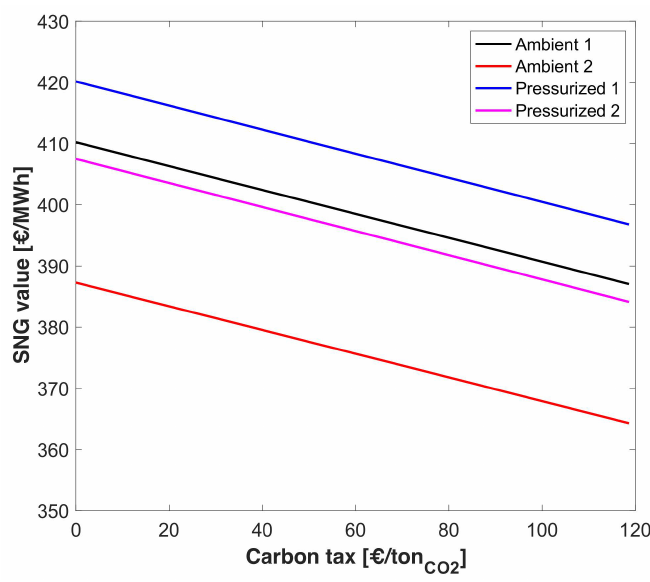
Figure 11. SNG value as a function of the carbon